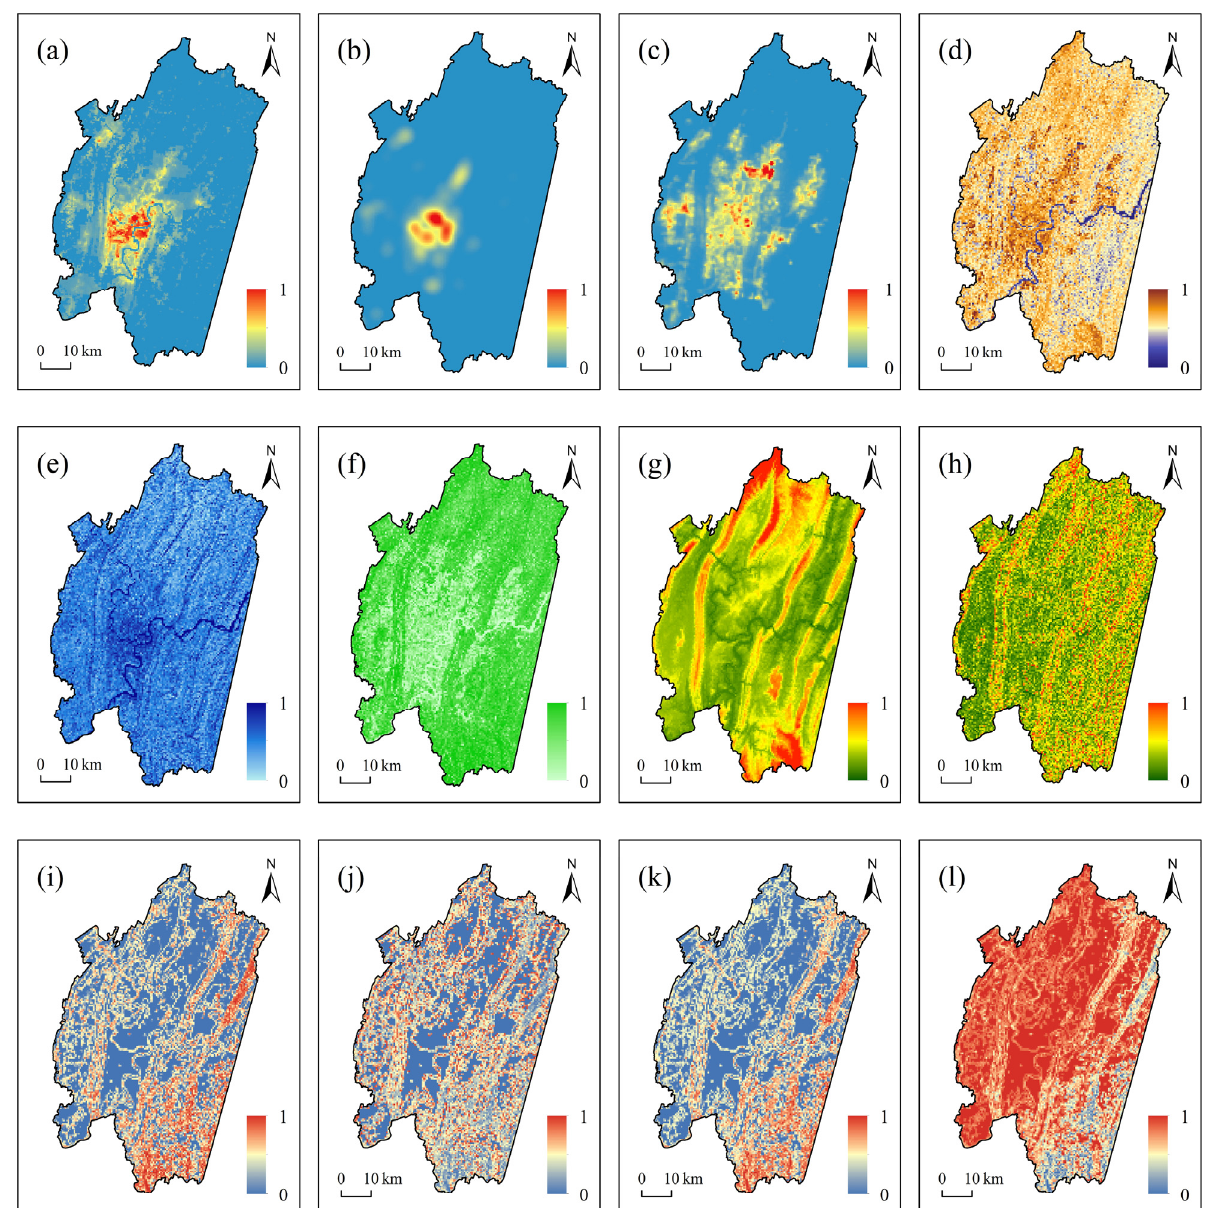
Figure 5. Spatial distributions of the factors influencing the urban thermal environment in Chongqing. ( a ) Population density, ( b ) POI density, ( c ) nighttime light intensity, ( d ) NDISI, ( e ) MNDWI, ( f ) FVC, ( g ) DEM, ( h ) slope, ( i ) DIVISION, ( j ) CONTAG, ( k ) SHDI, ( l ) COHESION.